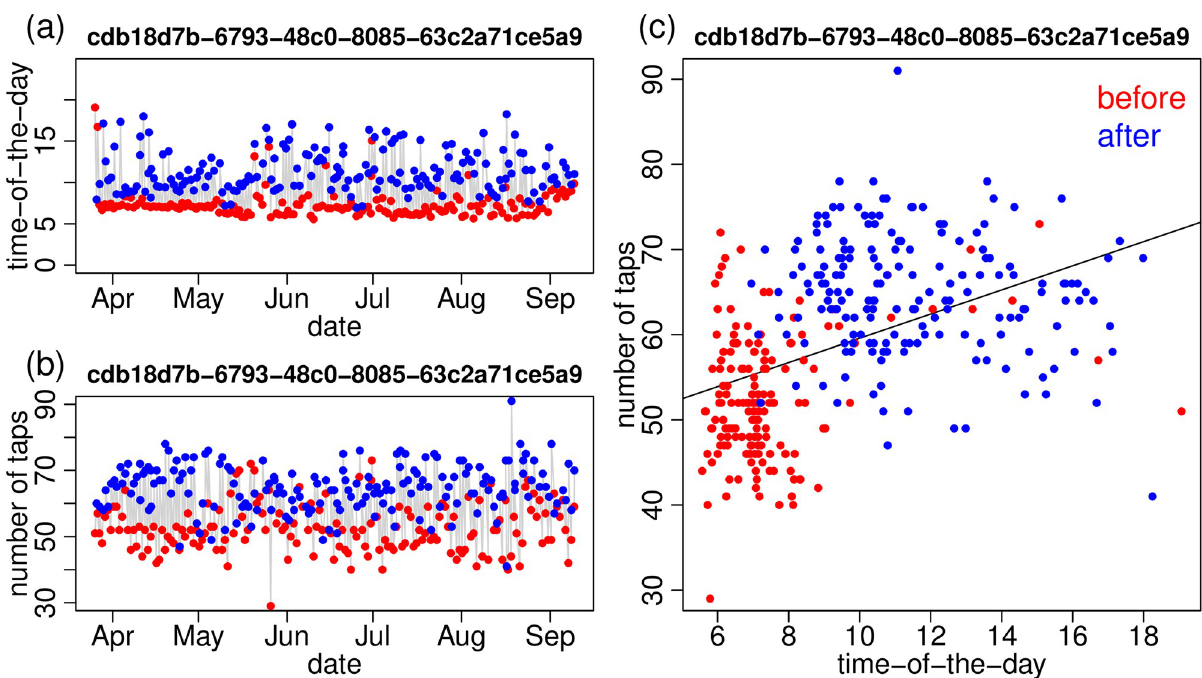
Fig 1. Marginal associations between treatment (before/after medication status), time-of-the-day and number of taps, for one study participant. Panel a shows that the participant usually performs the before medication tapping tasks (red dots) earlier in the day than the after medication tasks (blue dots). Panel b shows the participant also tends to achieve better performance (larger number of taps) in tasks performed after medication. Panel c, nonetheless, also shows that large number of taps tends to be associated with later times. Hence, it is possible that the medication and/or circadian rhythms/daily routine activities might be responsible for the difference in performance between the before and after medication tapping tasks observed in this participant.